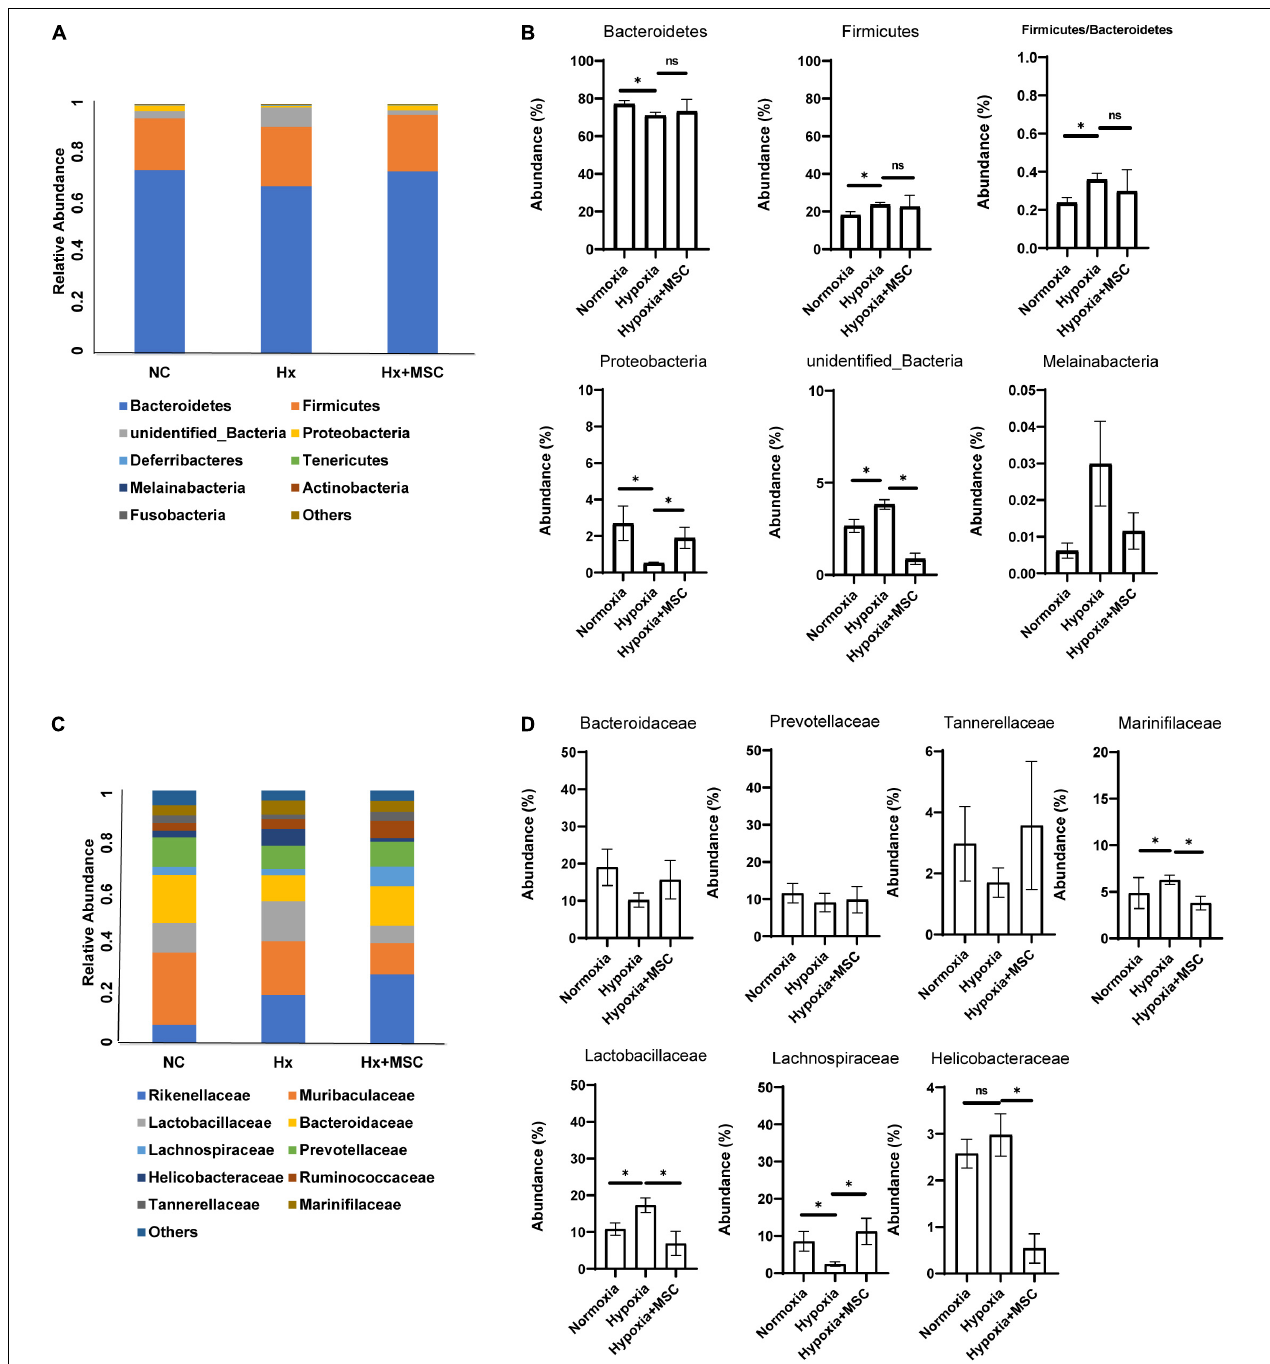
FIGURE 3 | Fecal microbial composition at the phylum level and family level. (A,B) The changes in Firmicutes , Bacteroidetes , Proteobacteria , unidentified_bacteria, Melainabateria , and the ratio of Firmicutes/Bacteroidetes . n = 4–5 per group; mean ± SEM; White’s non-parametric t -test, ∗ P < 0.05. (C,D) The most abundant taxon changes at the family level. n = 4–5 per group; mean ± SEM; White’s non-parametric t -test, ∗ P <